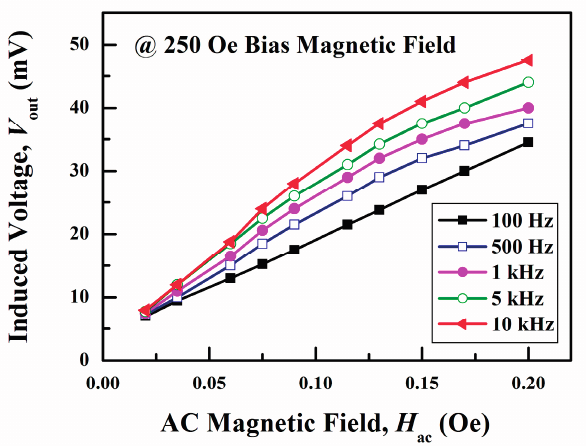
Figure 2. Induced voltage from the Permendur/PZT laminated composite as a function of ac magnetic field under various frequencies at the dc bias magnetic field of ~250 Oe.